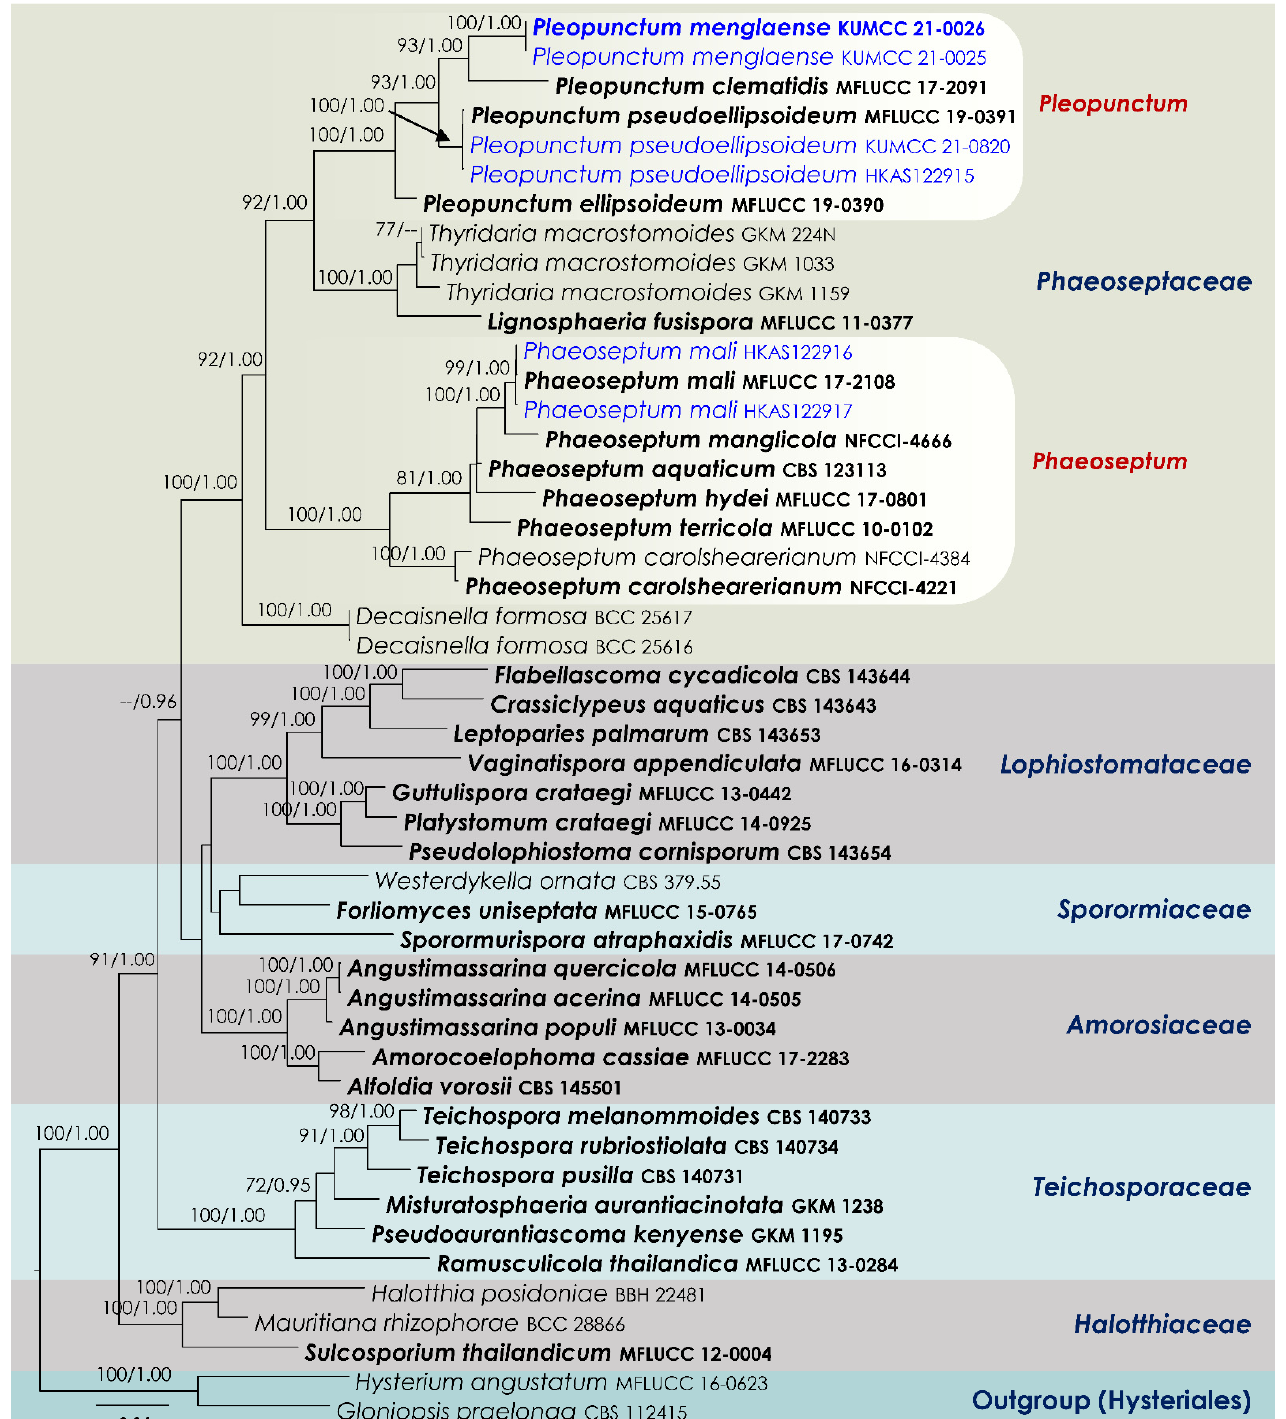
Figure 1. RAxML tree based on a combined dataset of a partial SSU, LSU, ITS, tef 1 and rpb 2 DNA sequence analysis in Phaeoseptaceae . Bootstrap support values for ML (MLB) equal to or greater than 70% and Bayesian posterior probabilities (BYPP) equal to or greater than 0.95 are shown as MLB/BYPP above the nodes. The new isolates are in blue. Species names given in bold indicate ex-type and ex-paratype strains. The scale bar represents the expected number of nucleotide substitutions per site.